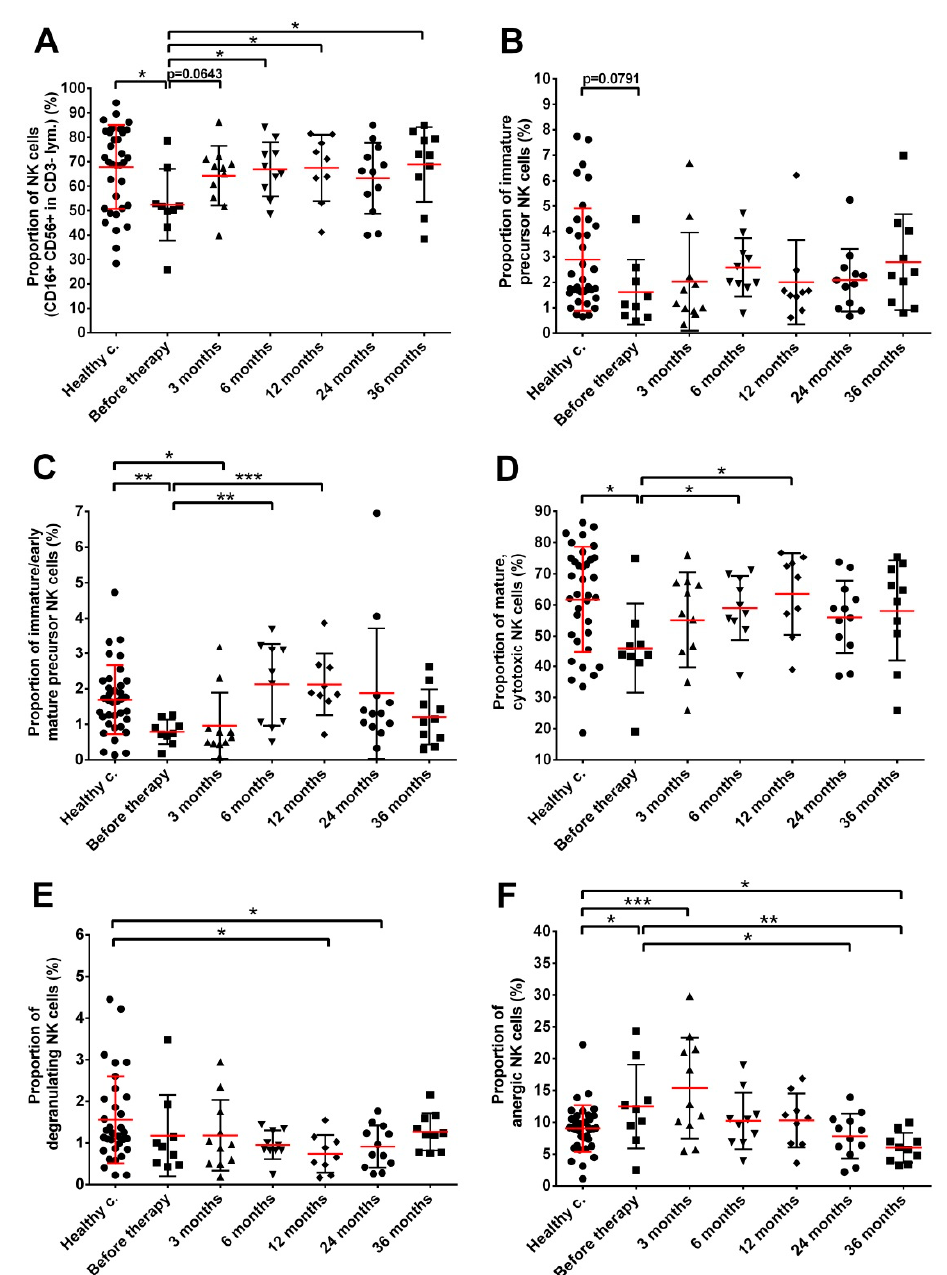
Figure 6. A pronounced redistribution occurs within the different NK cell subpopulations in prostate cancer patients treated with LDR brachytherapy. ( A ) circulating NK cells (CD16+CD56+CD3- lymphocytes), ( B ) immature precursor NK cells, ( C ) early mature NK cells, ( D ) mature, cytotoxic NK cells ( E ) degranulating NK cells levels, ( F ) anergic NK cells. Blood collection, processing and immune phenotyping were carried out as described in Materials and methods at the indicated time points relative to brachytherapy. n (healthy controls) = 10, n (cancer patients) = 8–18. Significant differences were indicated with * ( p < 0.05) ** ( p < 0.01) and *** ( p < 0.001). Natural killer T-like cells were identified as CD3+CD56+ cells within the lymphocyte gate. The level of NKT-like cells significantly decreased in prostate cancer patients before the start of the therapy compared to healthy controls (4.90% mean with 2.53–7.27% 95% CI and 9.11% mean with 7.21–11.02% 95% CI in patients before RT and healthy controls,